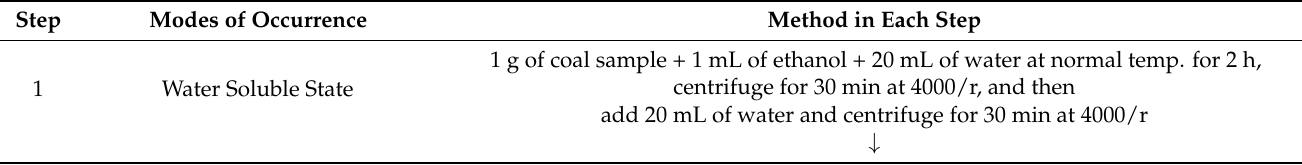
Table 1. The results of the six-step sequential chemical extraction procedure